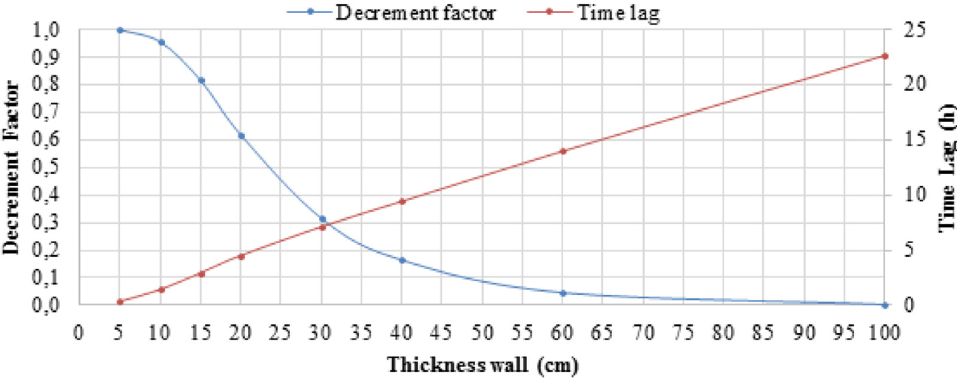
Fig. 4. Representation of decrement factor and time lag according to concrete thickness wall. Table 3. Summary of layer properties of the wall. Layer